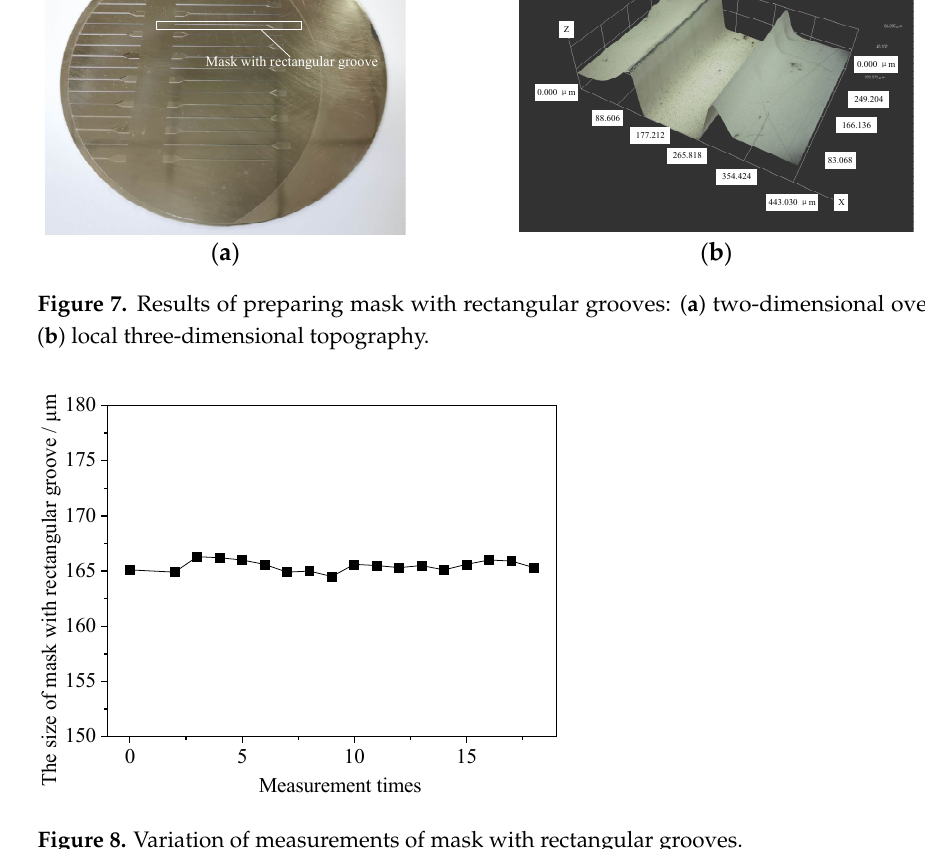
Figure 8. Variation of measurements of mask with rectangular grooves.